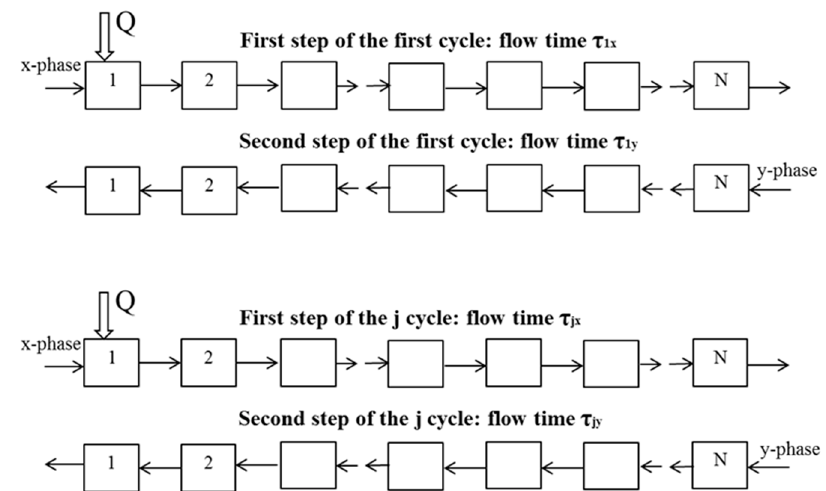
Figure 3. Schematic diagram of the mathematical model of multiple dual mode countercurrent chromatography with variable duration of phase elution steps and periodic sample injection.